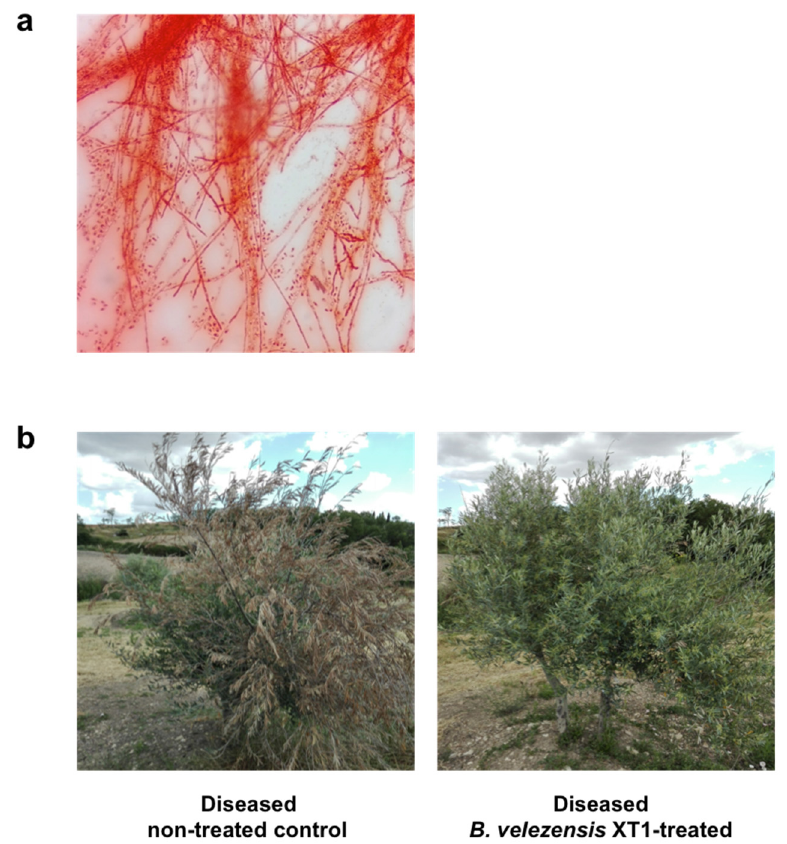
Figure 4. Palliative treatment of Verticillium wilt on diseased adult olive trees by Bacillus velezensis XT1. ( a ) Microscopic observation of V. dahliae isolated from affected trees. ( b ) Olive trees in the field experiment before and after the treatment with strain XT1. Control consisted of diseased non-treated trees.